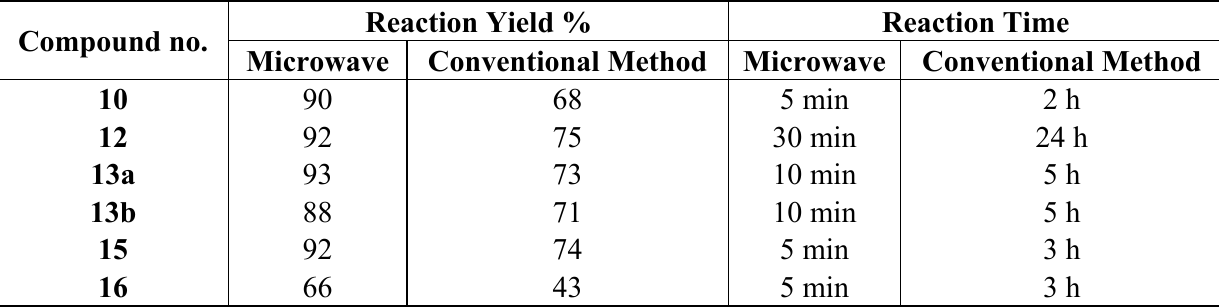
Table 1. Comparison between traditional methods and microwave assisted methods of synthesis of compounds 10 , 12 , 13a , 13b , 15 and 16